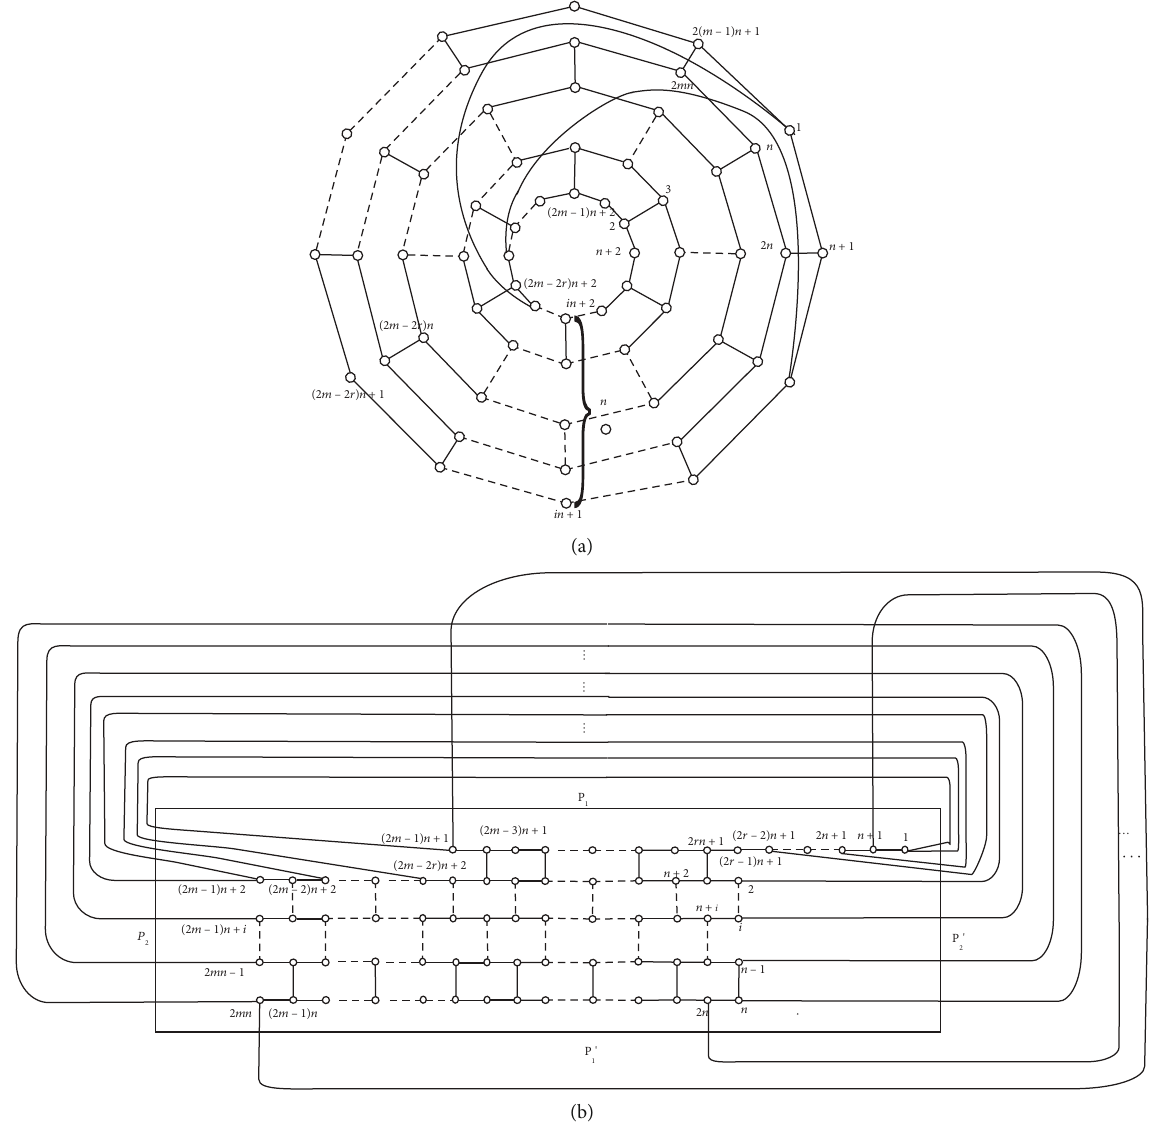
Figure 3: H embedded on a torus and a corresponding plane model, where n is 2 m , n , r